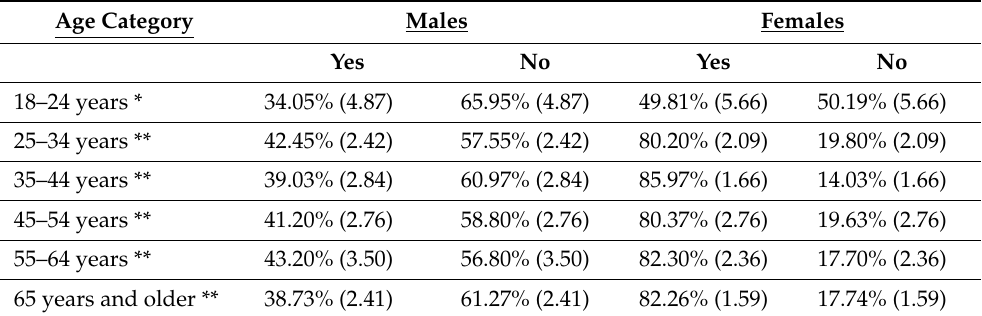
Table 2. Participants’ replies to the question “Are you the person who does most of the planning or preparing of meals in family?” stratified by age category.